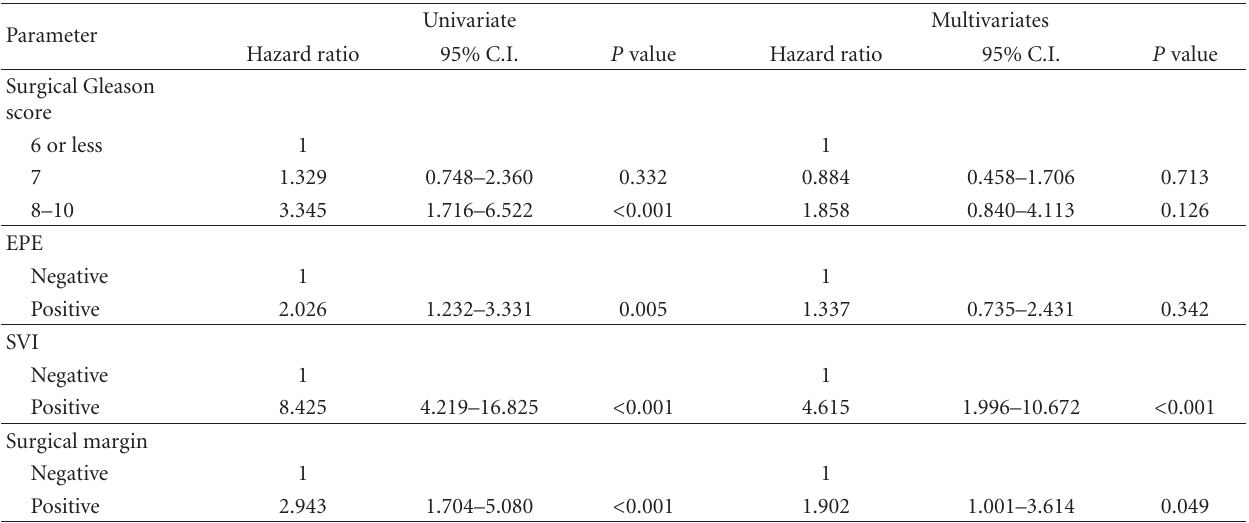
Table 4: Univariate and multivariate analysis in postoperative clinicopathological